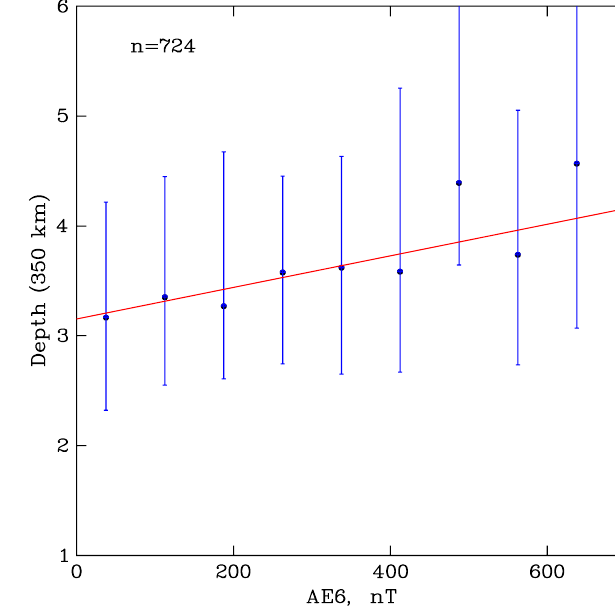
Fig. 9. Magnetic activity dependent changes in the magnitude of the density drop in the equatorward trough wall. The format of data presentation corresponds to that of Fig. 6 except that the height is replaced by the AE 6 index. The regression line fitted to the median values is given in Eq. (8). All data refer to a common reference altitude of 350 km. Note that the correlation coefficient for this data set is rather low, r = 0 . 25, indicating that the dependence of the trough depth on the AE 6 index is surprisingly weak, at least on